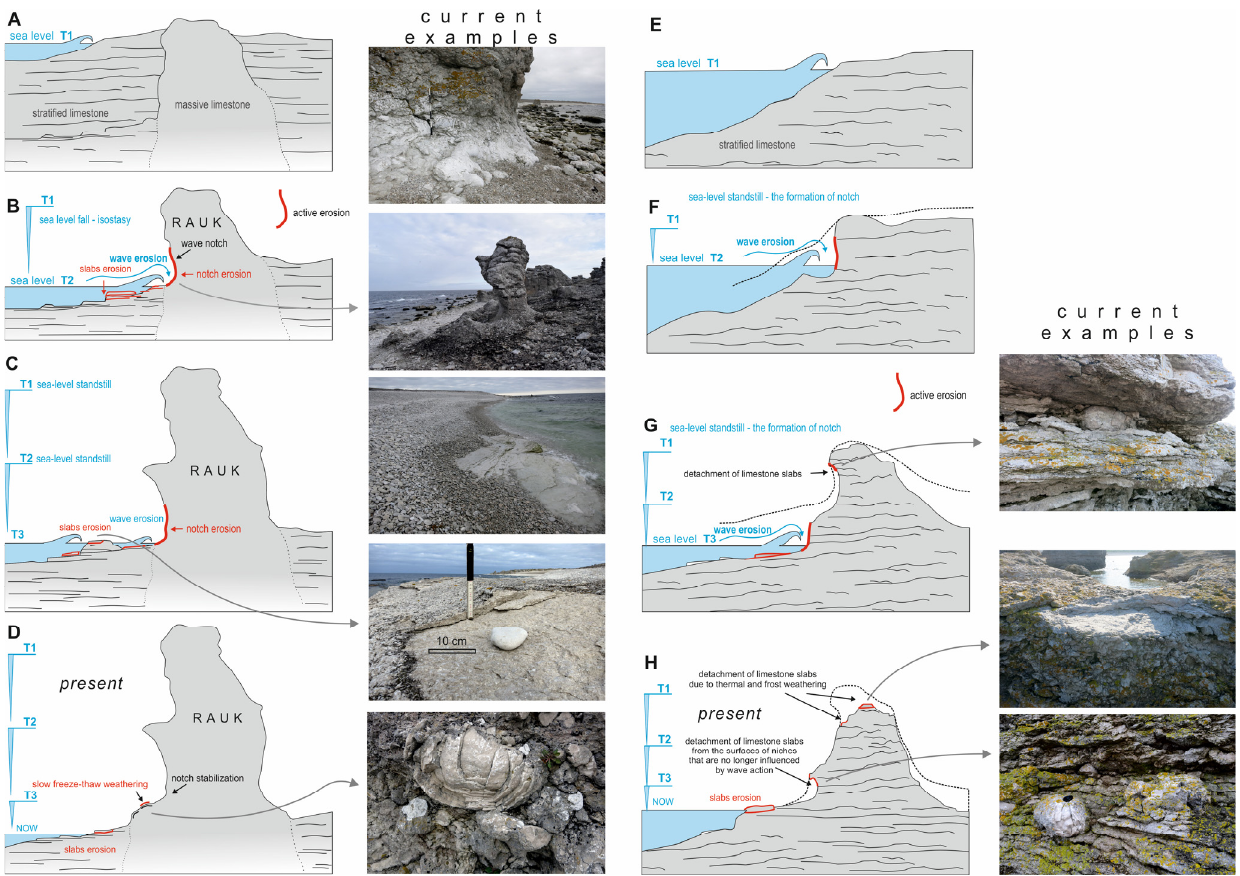
Figure 12. The concept of rauk coastal system development ( A – D ) massive limestone rauks, ( E – H ) stratified limestone rauks) on Fårö Island emerged on the basis of our own field surveys, including but not limited to surveys based on TLS point cloud analysis and reference literature: ( A ) rocky coast built from stratified limestone and massive limestone that later developed into rauks; ( B ) period of a uplift of the rauk field due to glacio-isostatic rebound, development of notches due to the direct impact of waves on hard limestones, dislodgement of stratified limestone; ( C ) another period of sea-level stabilisation and wave erosion. Development of a new level of notches; ( D ) present- day. Notches out of the reach of waves. Erosion of limestone slabs and frost weathering of rock surface; ( E ) rocky coast built from laminated limestone—at the onset after the outcrop—ice sheet retreat; ( F ) period of a stable sea-level and wave operation on rauk surface; ( G ) subsequent period of sea-level stabilisation. Development of a lower level of notches. Destruction of rauks by waves and dislodgement of the top layers due to frost weathering; ( H ) further disintegration of the